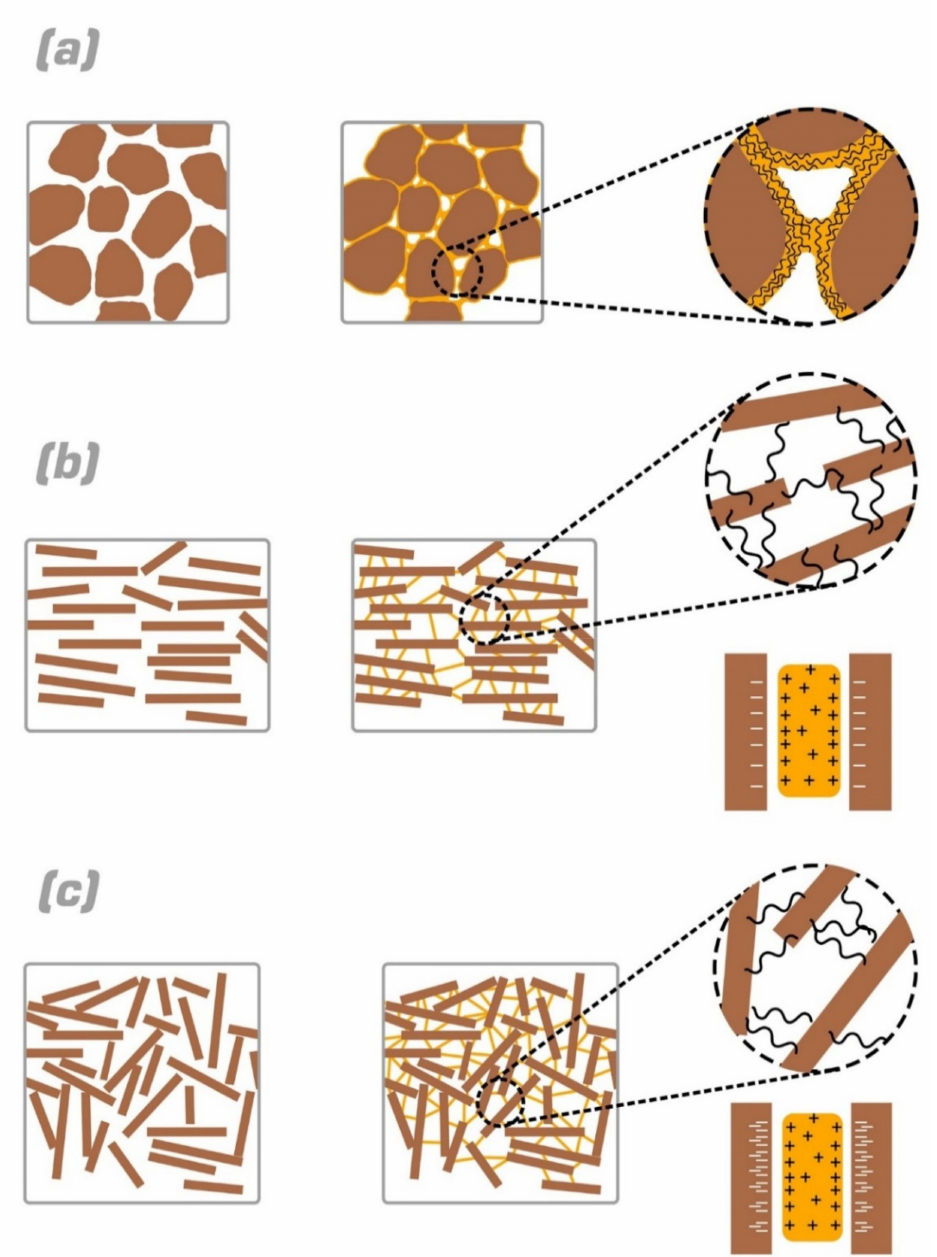
Figure 3. Biopolymer interaction with different kinds of soils ( a ) sand, ( b ) kaolinite clay, ( c )